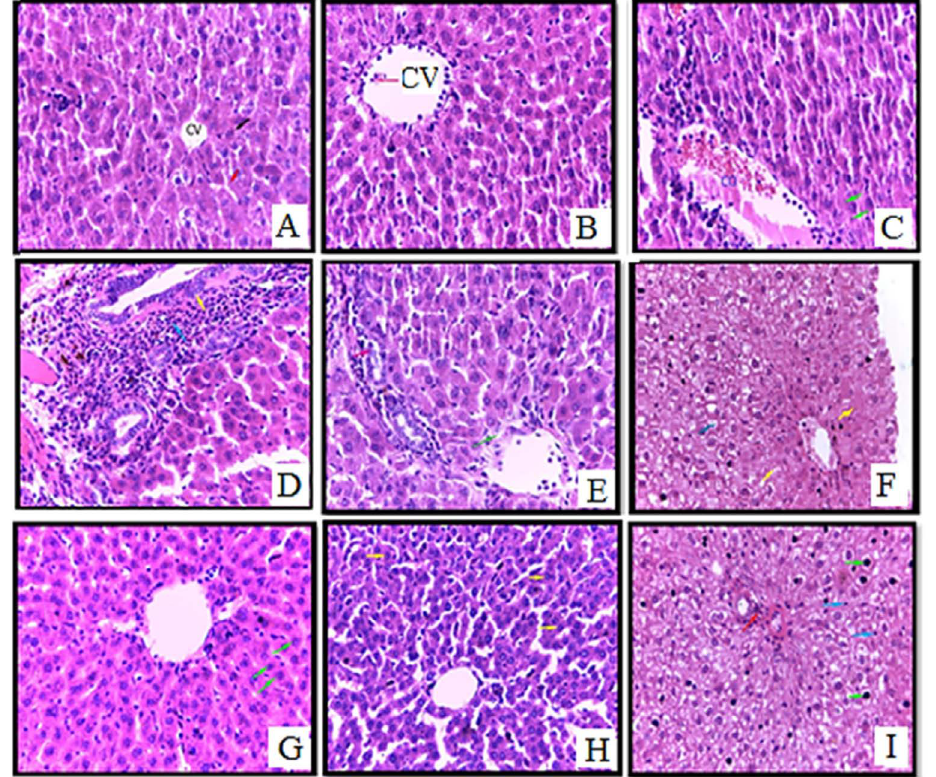
Fig. 2. HE stained liver sections from rats A- Control (showing normal tubular epithelial cell, no necrosis noted) B-D high dose MTX: B- infiltration of inflammatory cells around the central vein: C- congestion and infiltration cells with the decomposition of hepatic cell edge:D- hyperplasia in the bile ducts: E- vascular cytoplasm of cells, degeneration in endothelial of vessels and bile ducts epithelial: F- hepatocytes necrosis and nuclei disintegration: G-I, group treated with Methotrexate and clove essential oil: G-no presence inflammatory in the liver tissue: H- presence of renewable hepatocytes: I- Kupffer appeared normal but can see thickness of nuclei . CV in A, B = Central vein (Magnifications, all 470